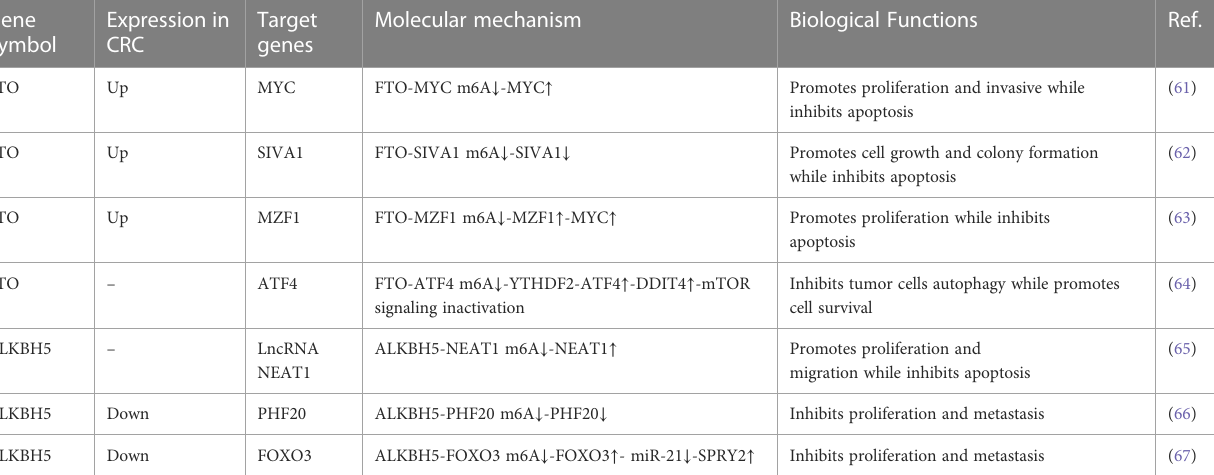
TABLE 2 Functions of m6A “ erasers ” in